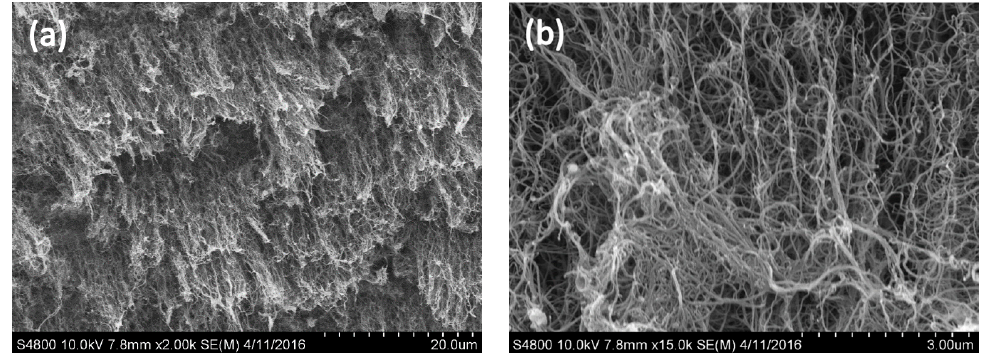
Figure 6. SEM images of carbon nanotubes formed using argon gas flow rate of 800 sccm: ( a ) Magnified 2000 times; ( b ) Magnified 15,000 times.